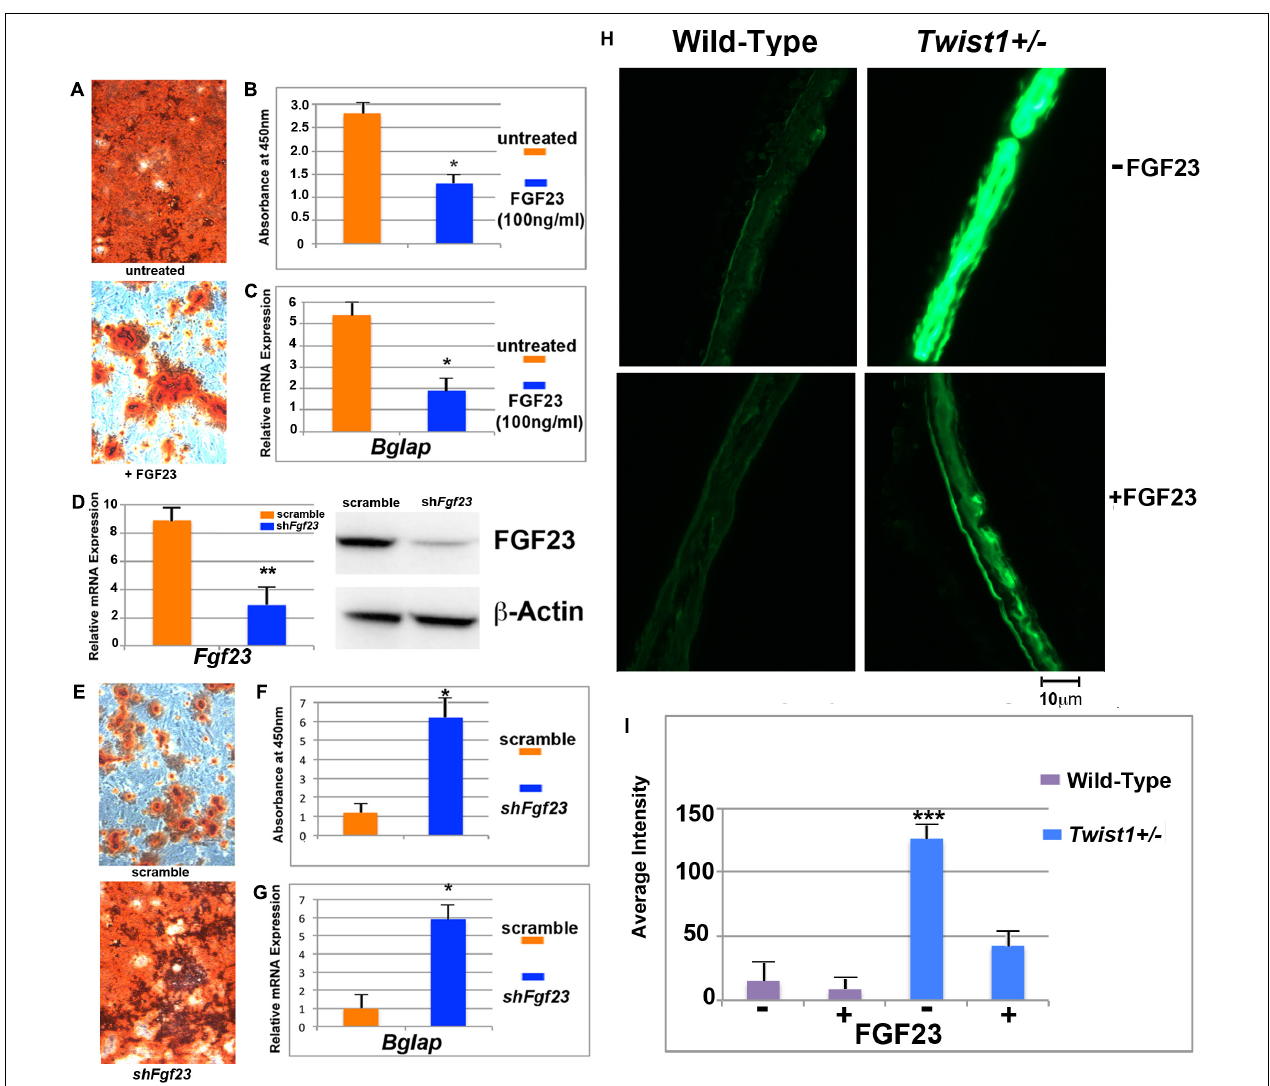
FIGURE 5 | Inhibition of osteogenesis and bone mineralization by exogenous FGF23 protein. (A) Treatment with FGF23 protein (100 ng/ml) suppresses markedly osteogenic differentiation of Twist + / − POb as revealed by Alizarin red staining performed at differentiation day 28. (B) Quantification of Alizarin red staining for the osteogenic assay shown in panel A (C) RT-qPCR analysis of the osteogenic marker osteocalcin ( Bglap ) confirms that FGF23 treatment abrogates the enhanced osteogenic of Twist1 + / − POb. (D) Validation of effective Fgf23 silencing monitored by RT-qPCR (left panel) and immunoblotting analysis (right panel). (E) Fgf23 silencing enhances the osteogenic capacity of wild-type POb mirroring that of Twist1 + / − POb as revealed by Alizarin red staining. (F) Quantification of Alizarin red staining for the osteogenic assay shown in panel E . (G) osteocalcin ( Bglap ) expression by RT-qPCR analysis confirms increased terminal differentiation in sh Fgf23 POb compared to scramble POb. (H) Exogenous added FGF23 also decreases dramatically bone mineralization in parietal bone organ culture. Calcein was added to the cultures for 48 h. Immunofluorescence showing calcein accumulation into the bone. (I) Histomorphometric analysis of calcein accumulation. Scale bar, 10 µ m. Results are representative of three independent experiments performed. Values: ∗ p ≤ 0.05, ∗∗ p ≤ 0.01, and ∗∗∗ p ≤